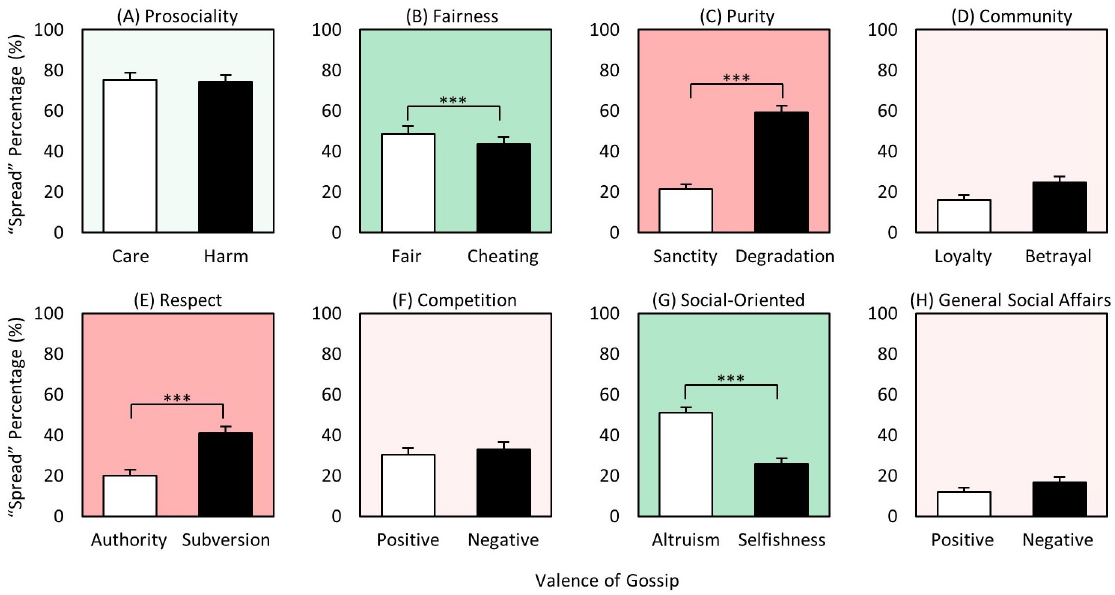
Fig 11. Mean gossip spread rates about outgroup targets for positive versus negative events. The graphs with green shade ((B) & (G)) are those with higher positive spreading rates than negative spreading rates. The graphs with red shade ((C) & (E)) are those with the opposite pattern. The graphs with pale green (A) and pale red ((D), (F) & (H)) are not statistically significant yet show the trends of the graphs with the corresponding colors. � p < 0.05, �� p < 0.01, ��� p < 0.001.